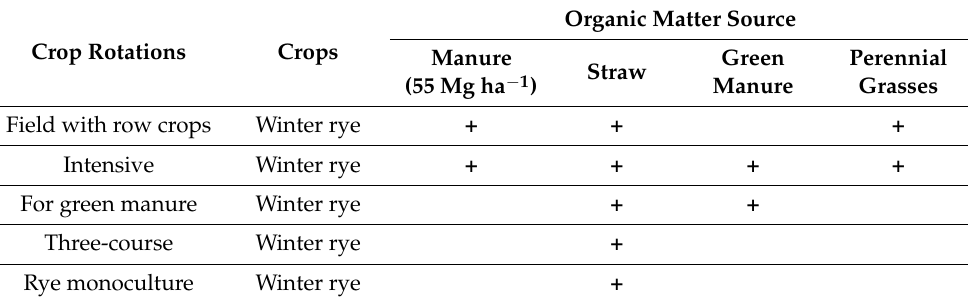
Organic Matter Source Green Perennial Manure Straw Manure Grasses (55 Mg ha − 1 )